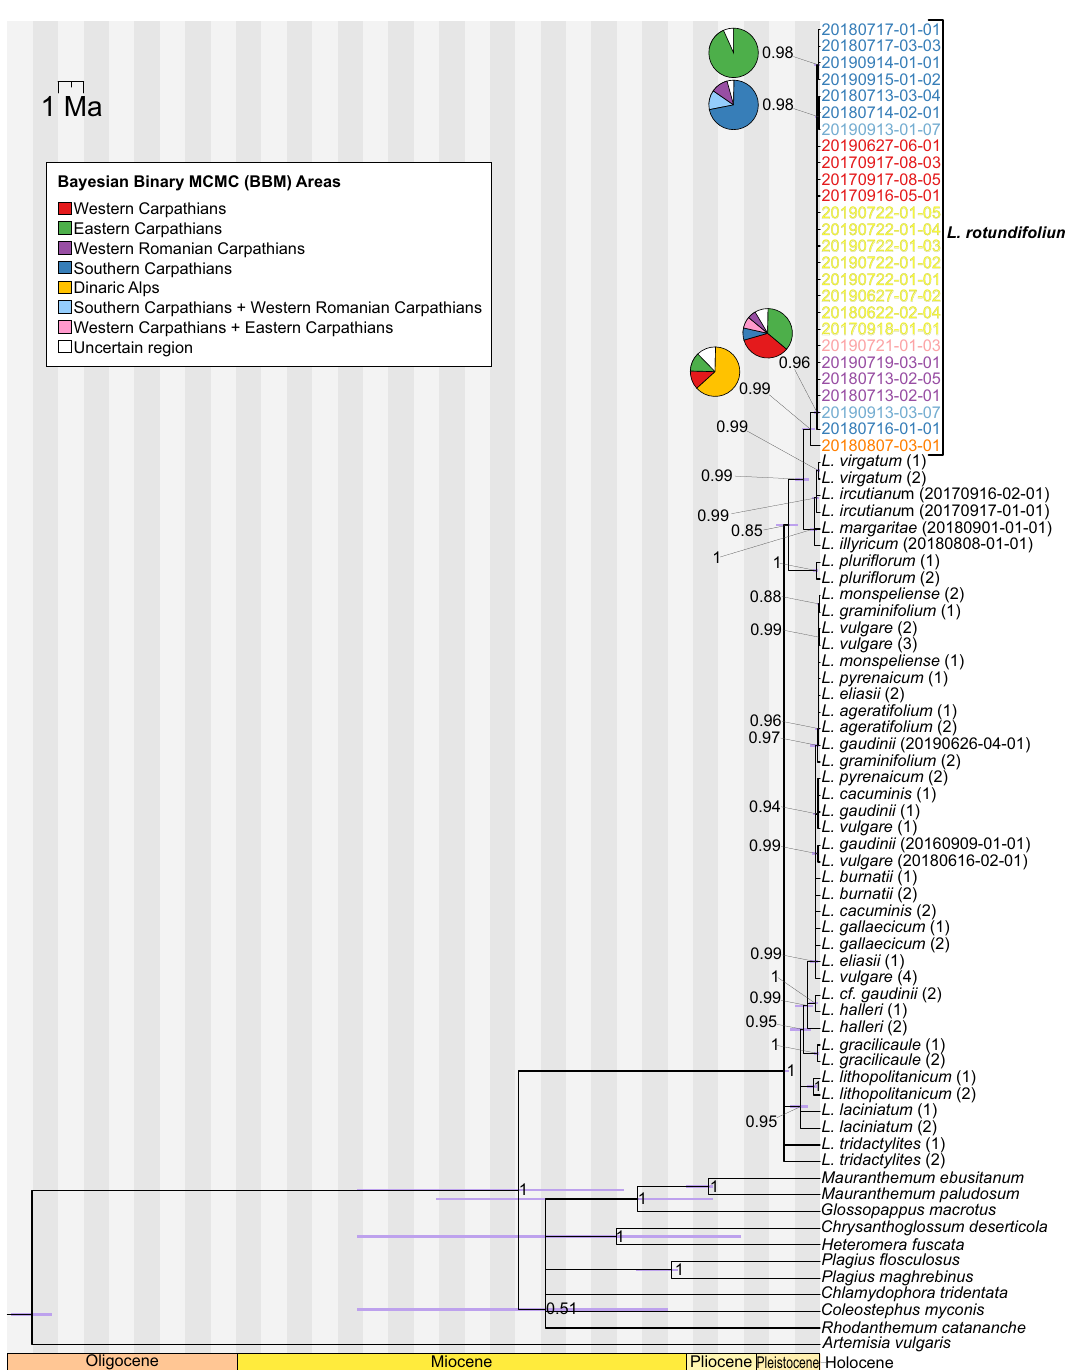
Figure 2. Phylogenetic tree constructed using five intergenic spacer regions in cpDNA ( psb A -trn H, trn L -trn F, trn C -pet N, pet N -psb M, and trn Q -rps 16). The numbers associated with the nodes indicate posterior probabilities from Bayesian analysis. Bars represent uncertainty in the dating of a particular node. Pie charts represent the most plausible ancestral locations inferred by the Bayesian binary Markov Chain Monte Carlo method (BBM), and are shown only for nodes associated with the focal species. The samples of L. rotundifolium are colored according to the results of the clustering algorithm (Fig.